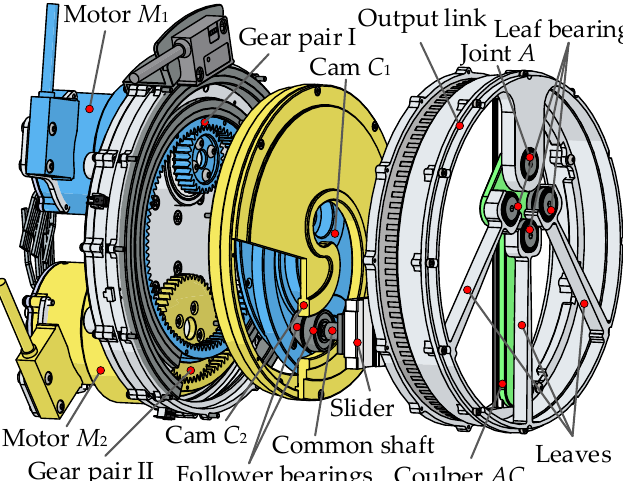
Figure 13. CAD model of the physical prototype. Physical prototype of reconfigurable cams. The symmetrical cams C 1 and C 2 in Figure 14a,b was machined with the same pitch curve in Figure 10. It focuses on optimal load distribution for output torque enhancement of the VSA. By changing the cam groove shape, the performance of the VSA can be reconfigured, as described in case 1 and case 2.